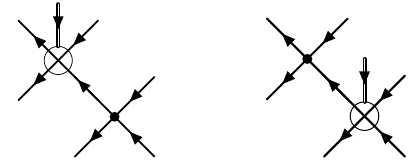
Figure 8 . Length-two three-particle tree-level form factor